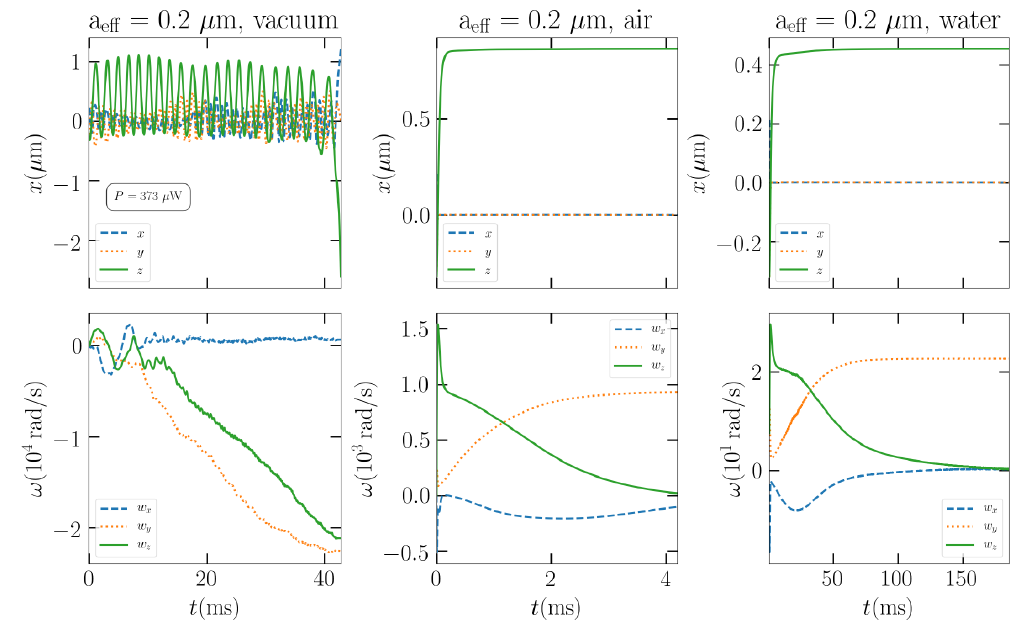
Fig 4. The a eff = 0.2 μ m cube in the LG 00 trap immersed in vacuum (left), air (middle), and water (right). The beam powers are 373 μ W, 230 mW, and 230 mW, respectively.